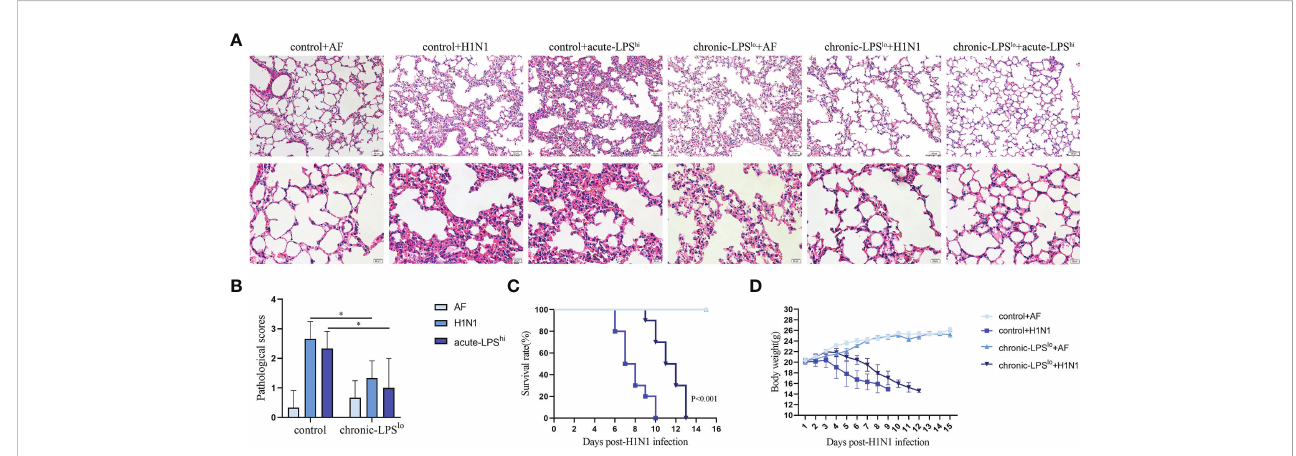
FIGURE 1 The effect of chronic low-dose LPS stimulation on lethal IAV infected mice. (A) Female BALB/c mice (n = 3 mice/group) were intranasally infected with 10 LD 50 H1N1 in fl uenza virus or an equivalent dilution of non-infectious allantoic fl uid (AF). The lungs were isolated and sectioned for hematoxylin & eosin staining. (B) Pathological scores of the stained sections. (C) Survival data of female BALB/c mice (n = 10 mice/group) after intranasal infection with 10 LD 50 H1N1. (D) Body weights of female BALB/c mice (n = 10 mice/group) after intranasal infection with 10 LD 50 H1N1. *p<